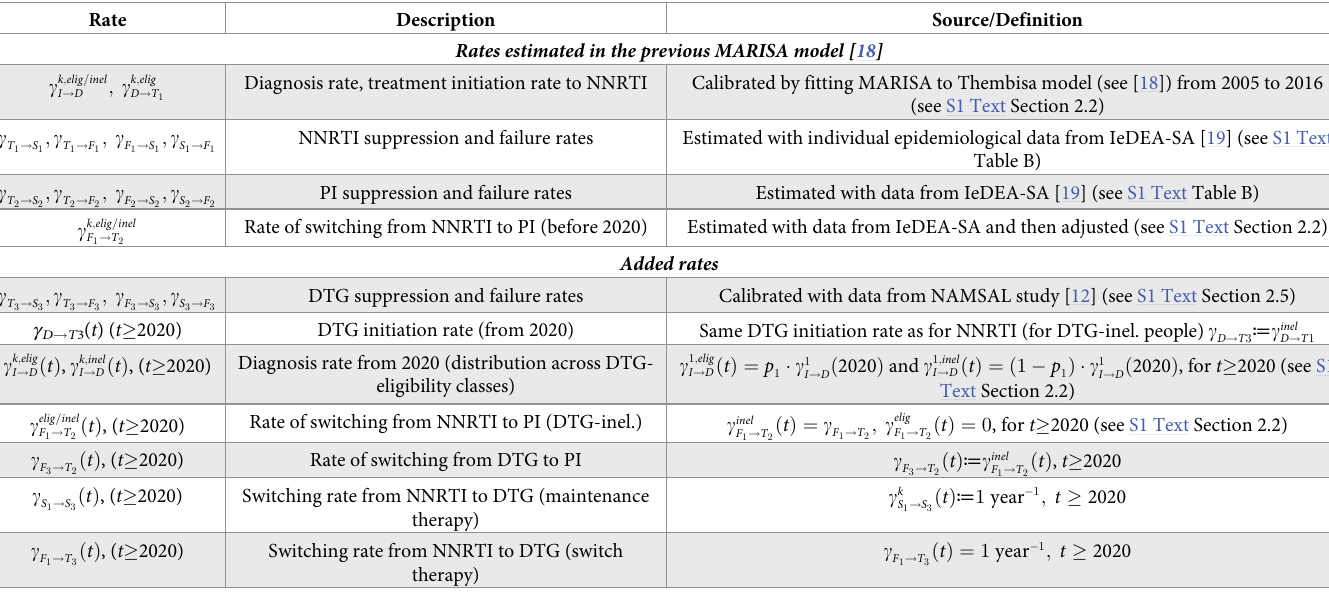
Table 1. Main parameters used in the extended MARISA